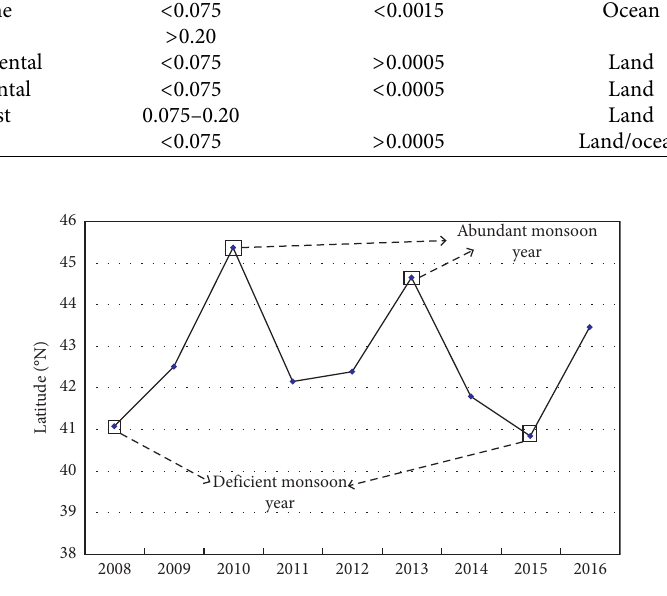
Figure 2: New East Asian summer monsoon index (NEWI) of 2008–2016.